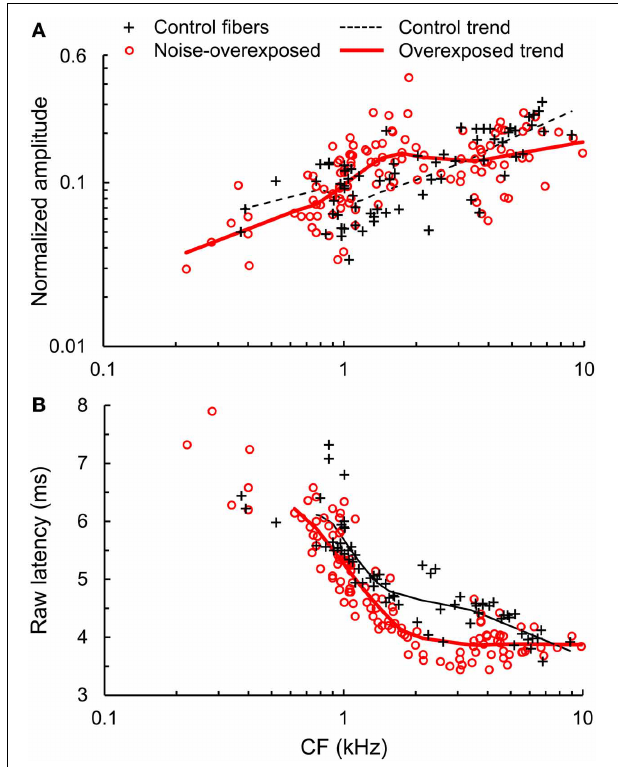
FIGURE 8 | Amplitude and latency of temporal envelope coding. (A) Normalized amplitude and (B) raw latency of temporal envelope coding plotted as a function of CF in normal hearing and noise-overexposed auditory-nerve fibers. Trend lines are based on local regression analyses. Latency values include a system delay in addition to neural response latency. Noise overexposure was associated with amplified envelope coding in fibers with CFs from 1 to 2kHz ( ∼ 50% amplification) and shorter response latency (by ∼ 0.4ms) across all